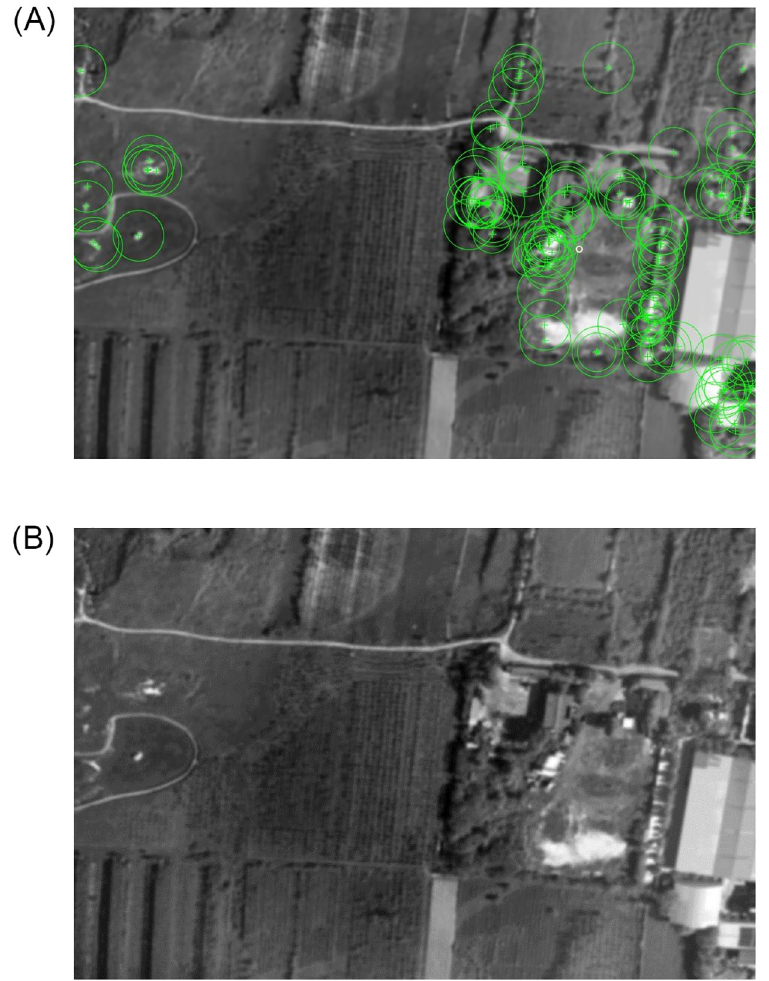
Fig 12. The extraction results of BRISK and FAST